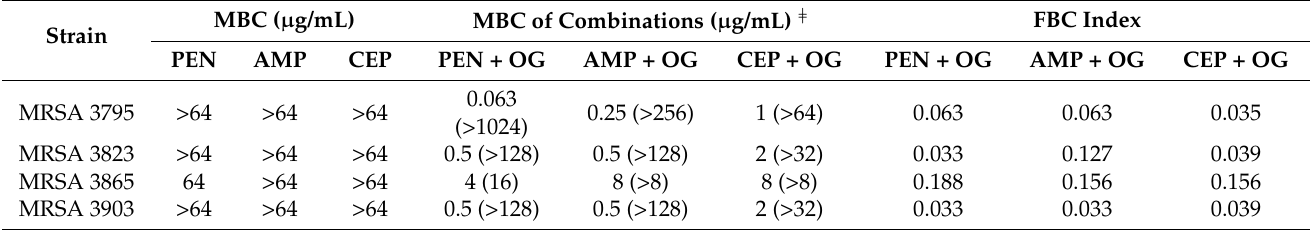
Figure 1. Synergistic bactericidal activity of octyl gallate (OG) in combination with β -lactams, including ( A ) penicillin, ( B ) ampicillin, and ( C ) cephalothin. Table 3. MBC and FBC index of octyl gallate (OG) and β -lactam combinations against MRSA isolates from clinical cases in